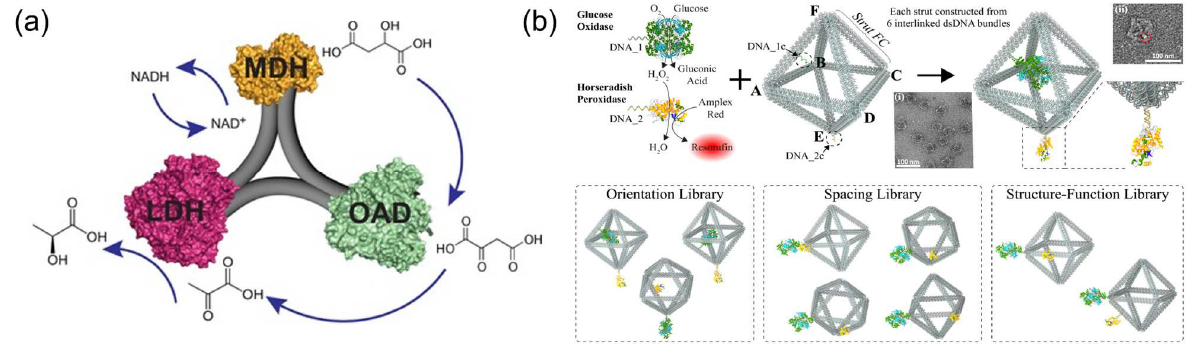
Figure 13. Enzyme cascade reactions on the DNA scaffolds to study the effect of spatial arrangement of enzymes. ( a ) Three types of enzyme, malic dehydrogenase/oxaloacetate decarboxylase/lactate dehydrogenase (LDH/MDH/OAD), co-assembled on a three-point star DNA scaffold to produce lactic acid from malic acid [103]. ( b ) The spatial arrangement of gOx and HRP on the DNA wireframe octahedrons [104]. Reprinted with permission from: ( a ) Ref. [103]. Copyright 2016 John Wiley and Sons.